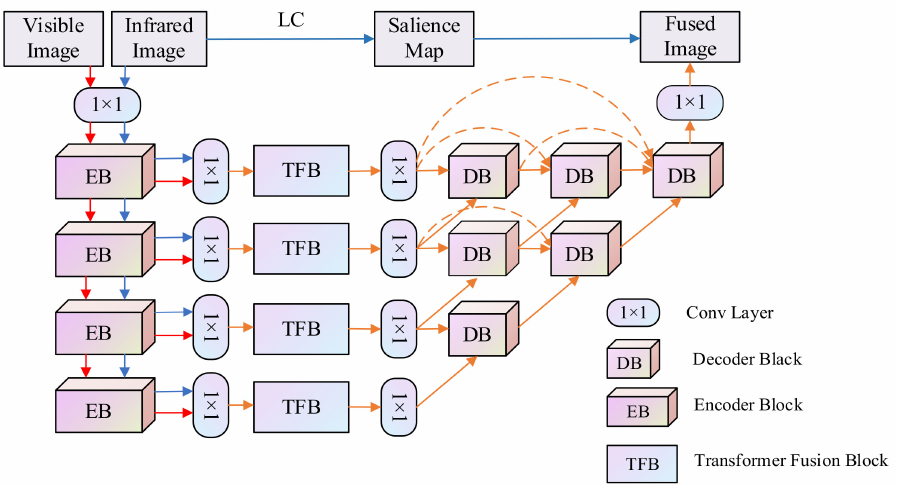
Figure 1. Overview of the proposed Multi-modal Feature Self-adaptive Transformer fusion